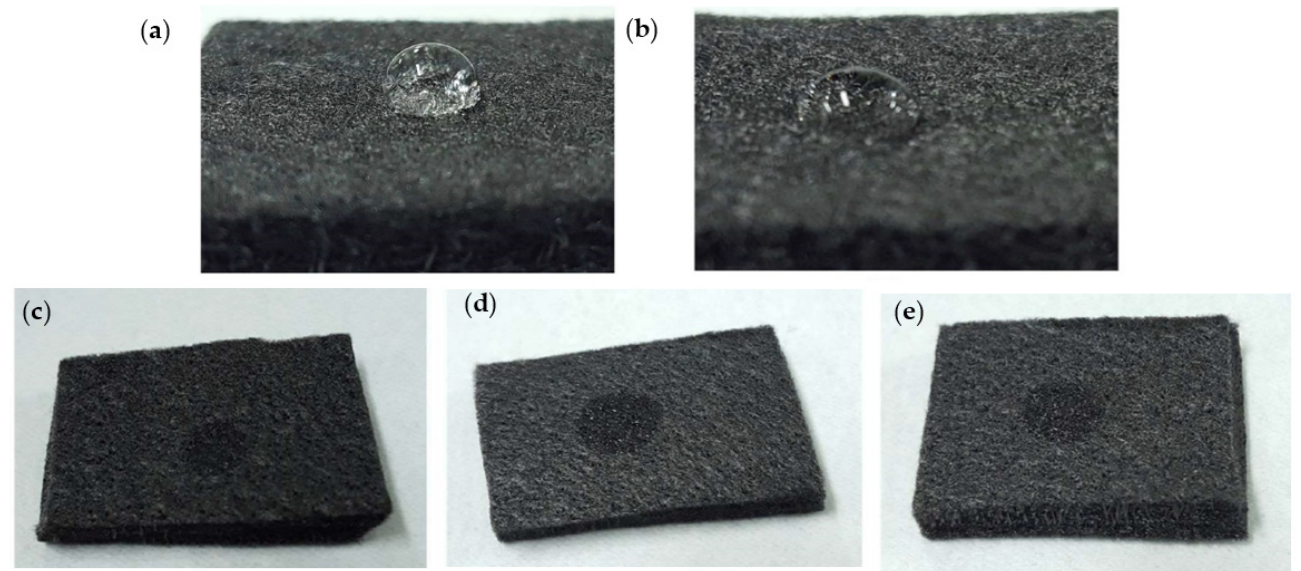
Figure 3. Photographic images indicative of the wettability of GF electrode: ( a ) untreated; ( b ) H 2 SO 4 treatment; ( c ) APPJ 450 °C treatment; ( d ) APPJ 550 °C treatment; ( e ) APPJ 650 °C treatment.